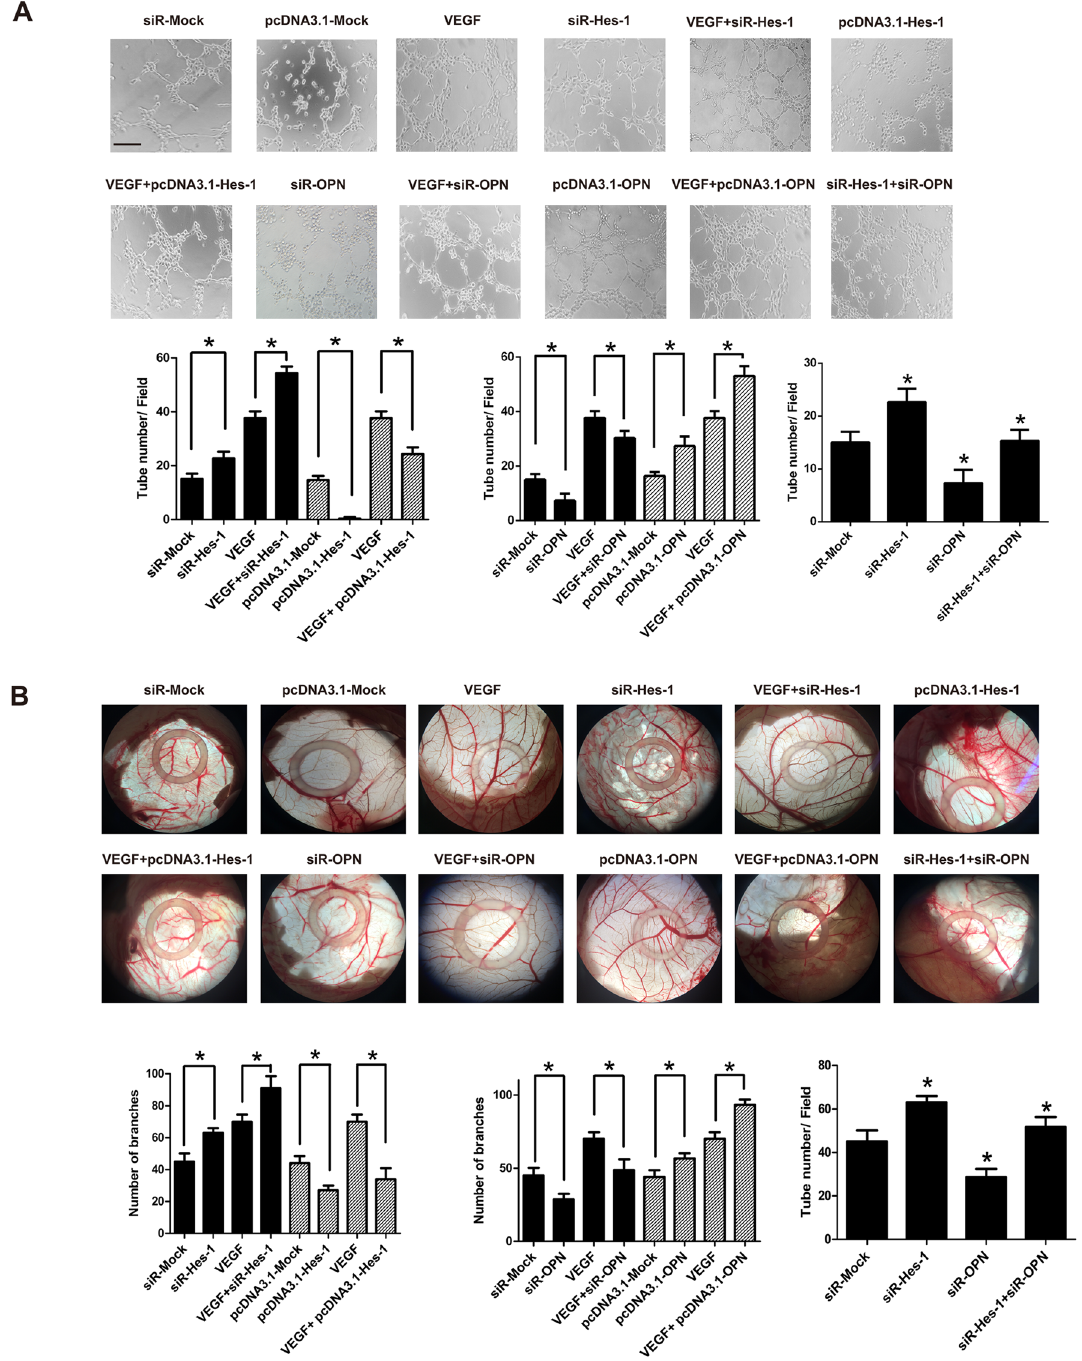
Figure 4. Hes-1 suppresses VEGF-induced angiogenesis via downregulation of OPN expression in vitro and in vivo . ( A ) HUVECs (1 × 10 5 ) treated with siRNA/ pcDNA3.1of Hes-1 or OPN and then incubated with or without 10 ng/mL of VEGF for 24 h were seeded on matrigel-coated plates. After 6 h of incubation, endothelial cell tubular structure formation was photographed and analyzed. The number of tubular-like structures was counted and indicated as the number of branches per field. Averages of tubules were calculated from four fields in each sample. Pictures were taken at 20x magnification. * p < 0.05. Bar: 400 μ m. ( B ) The CAM assay was done to assess angiogenesis in vivo , HUVECs (1 × 10 5 ) treated with siRNA/ pcDNA3.1 of Hes-1 or OPN and then incubated with or without 10 ng/mL of VEGF for 24 h were pipeted directly into the center of the silicone ring resting on the CAM. Sealed the window and incubated the egg for 48 h to observe the result of neovascularization. The CAM surface was photographed at the same position with a digital camera, and the area of newly formed vessels was calculated. The data are presented as mean ± SD of three independent experiments. * p <